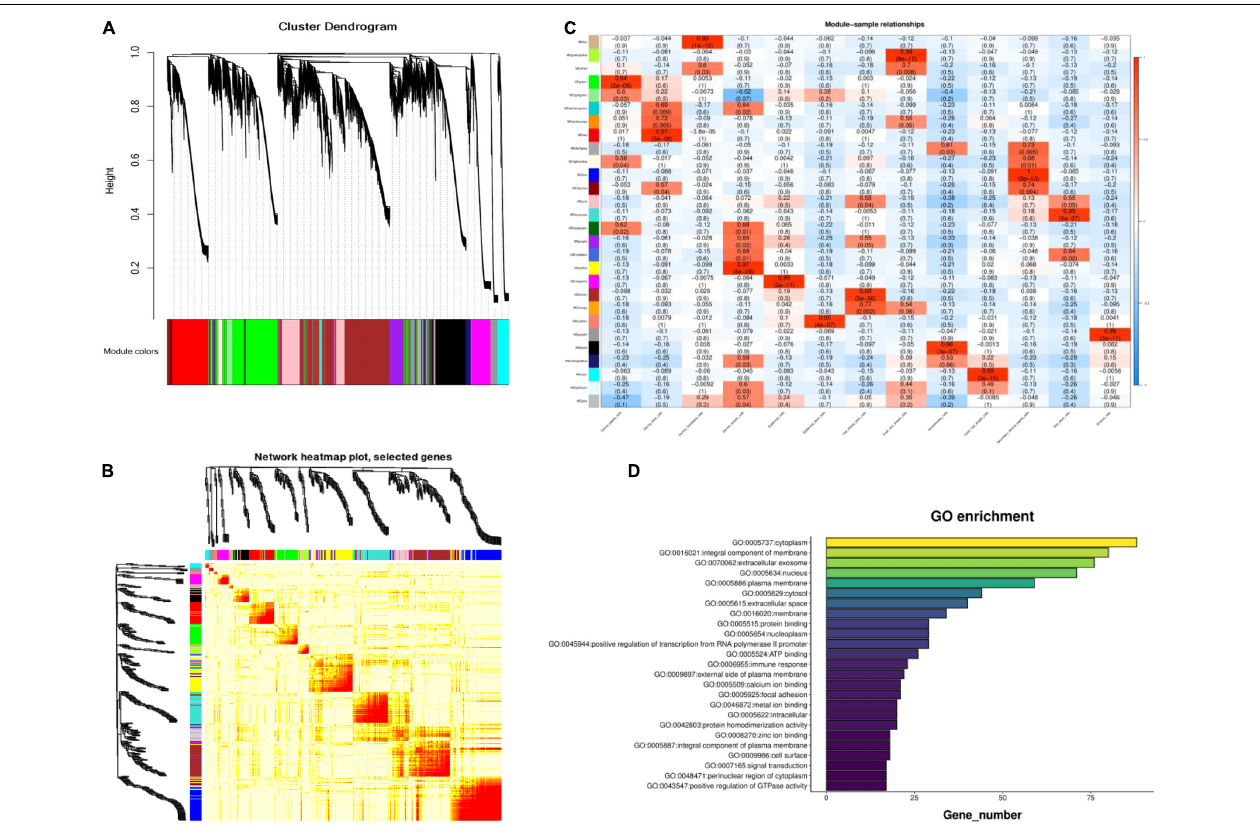
FIGURE 3 | Module identification of cashmere goat skin. (A) Cluster dendrogram of all screened genes. (B) TOM of all screened genes. (C) Heat map of the correlation between modules and cashmere skin cells. Each specific color represents the specific gene module. (D) GO analysis of the core genes in blue